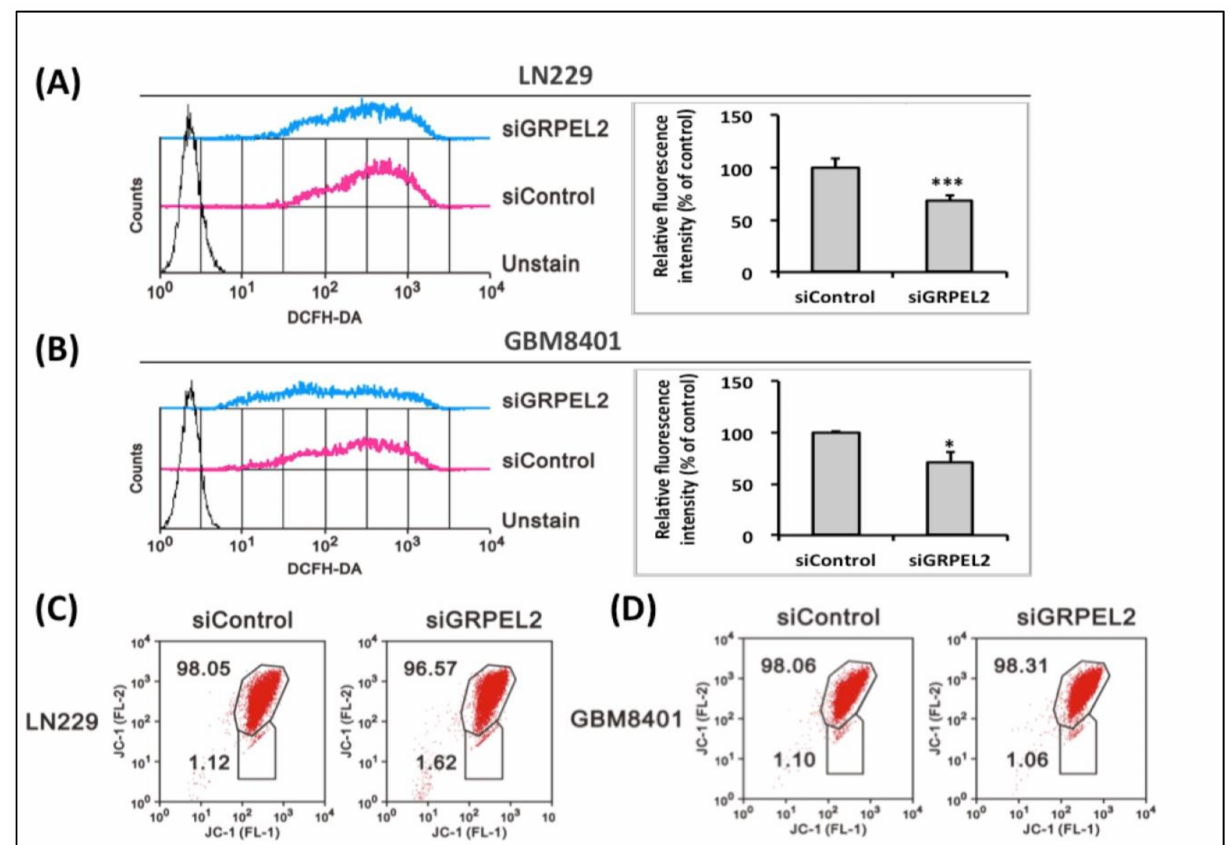
Figure 7. Effect of GRPEL2 knockdown on intracellular ROS and mitochondrial membrane potential (mt-MP) in glioma cells. ( A , B ) The LN229 ( A ) and GBM8401 ( B ) cells were treated with 25 nM siGRPEL2 for 24 h and stained with 2 (cid:48) -7 (cid:48) - dichlorodihydro fluorescein diacetate (DCFH-DA). The variation of the intracellular fluorescence intensity of LN229 and GBM8401cells was determined using flow cytometry (left panel). Relative fluorescence intensity analyses are shown on the right panel. * p < 0.05 *** p < 0.001. ( C , D ) Measure of mt-MP of LN229 ( C ) and GBM8401 ( D ) cells administrated with siGRPEL2 (25 nM) for 48 h by JC-1 assay. The data are representative of two independent